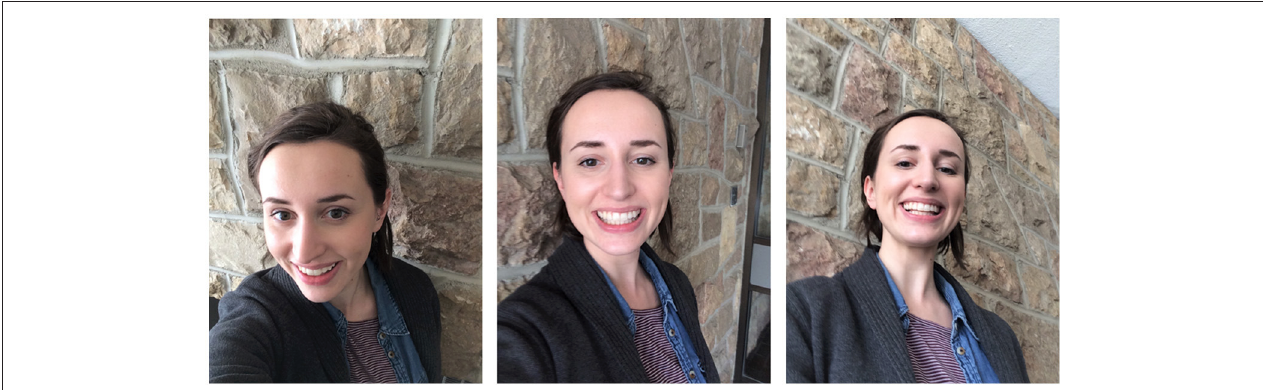
FIGURE 1 | Examples of vertical camera angle manipulation. From left to right, the presented images illustrate selfies photographed from an above, frontal, and below perspective. The portraits are modeled by a research assistant to maintain confidentiality of the sampled Tinder users.